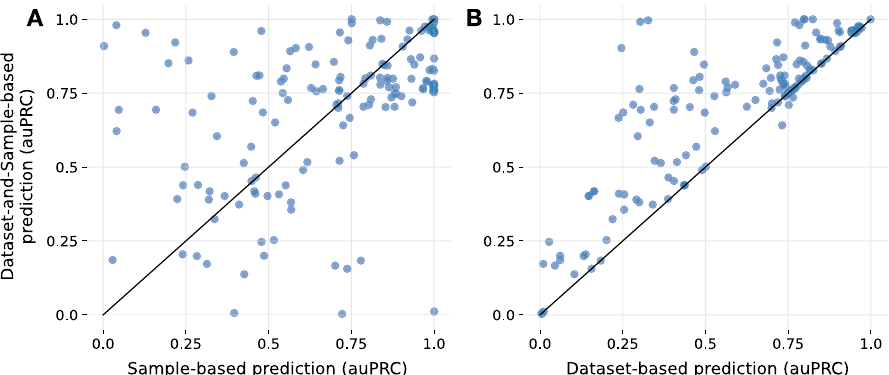
Fig. 3 | Metadata of sample ’ s parent dataset is useful but insuf fi cient to infer sample annotations. A Scatterplot of the area under the precision-recall curve (auPRC) scores of sample tissue predictions from just sample text ( x -axis) vs. combination of predictions from both sample and dataset text ( y -axis). B ) Scat- terplot similar to (and shares y -axis with) panel A but with auPRC scores of pre- dictions from just dataset text on the x -axis. Combination of dataset-and-sample-